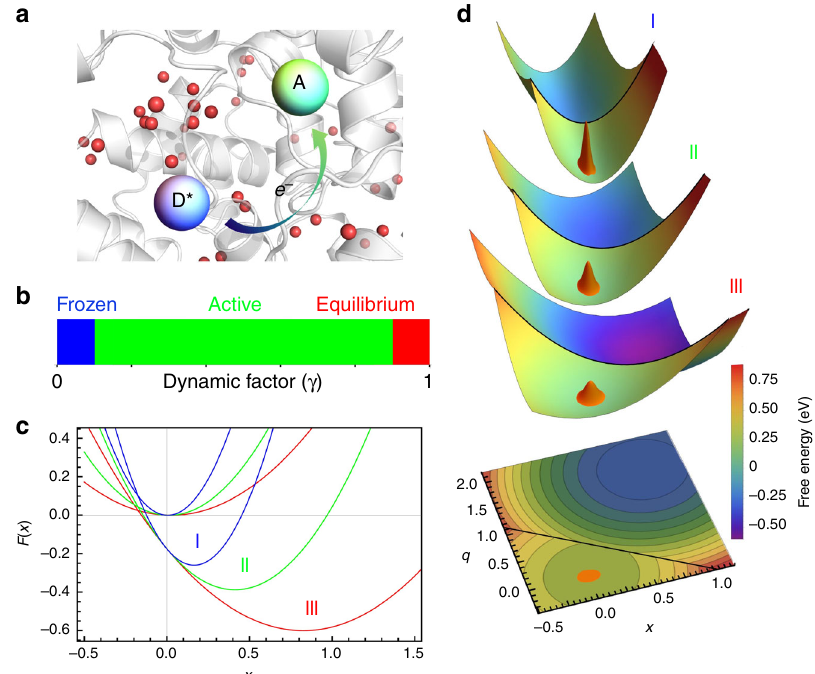
Fig. 1 Schematic representations of the ultrafast electron transfer model. a Cartoon illustration of a photo-excited electron transfer reaction inside a protein. b Three categories of ET reactions characterized by the value of dynamic factor γ (Eq. 16). c Free energy curves of three categories of ET reactions along the solvent coordinate x . Two curves with the same color, corresponding to the colored ET category in b , are related to the reactant (left curve) and product (right curve) states of a ET reaction, respectively (Eqs. 10a and 10b). d Free energy surfaces of three categories of ET reactions. Golden wavepackets represent the initial distributions, P ( x , t = 0) (Eq.